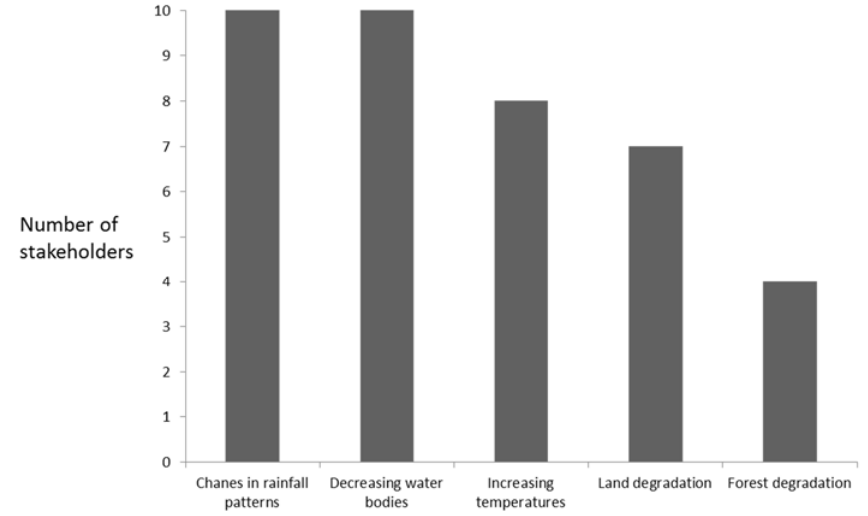
Figure 2. Perspectives on changing climatic conditions in the Bolgatanga Municipality, as indicated by interviewed stakeholders.